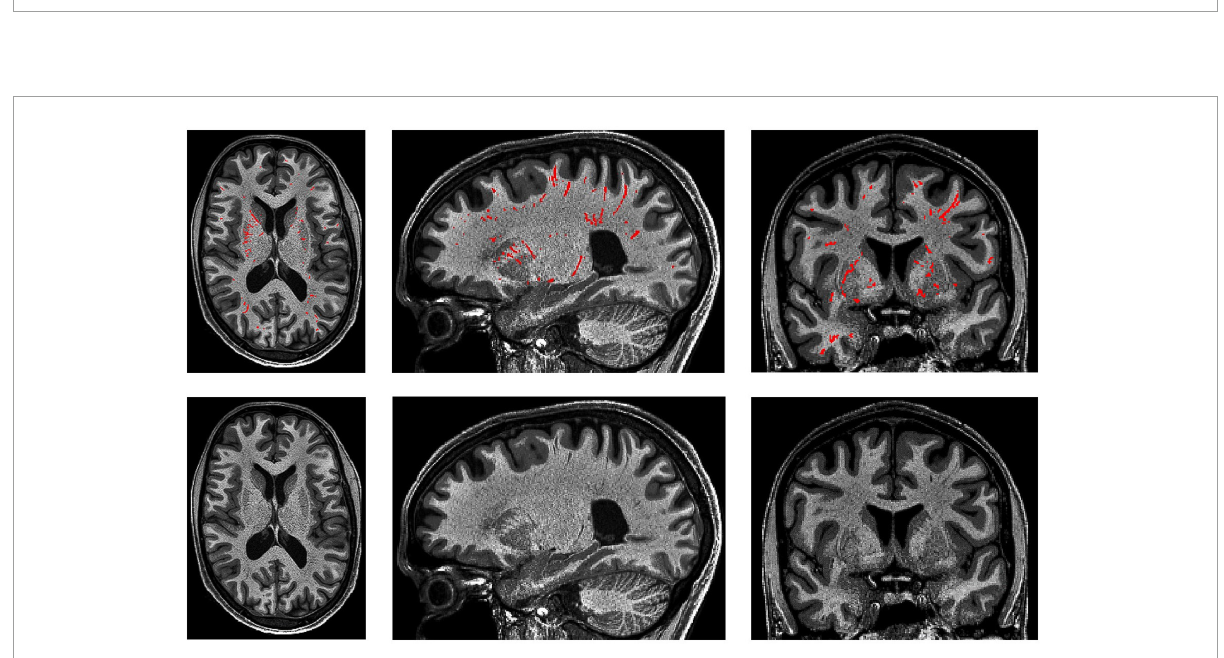
FIGURE10 3D PVS segmentation from a T1-weighted MRI scan. PVS voxels are labeled in red (top row), and the corresponding unlabeled slices are in the bottom row. Basal ganglia PVS are visible in the axial (left), sagittal (middle), and coronal (right)